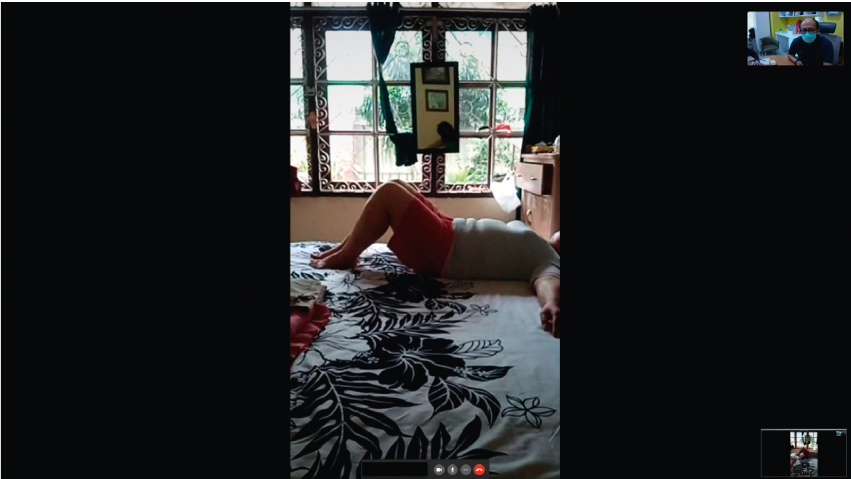
Figure 1: Patient’s active ROM examined during WhatsApp video call and recorded as a Table 1: Patients’ follow-up results from the virtual clinic.